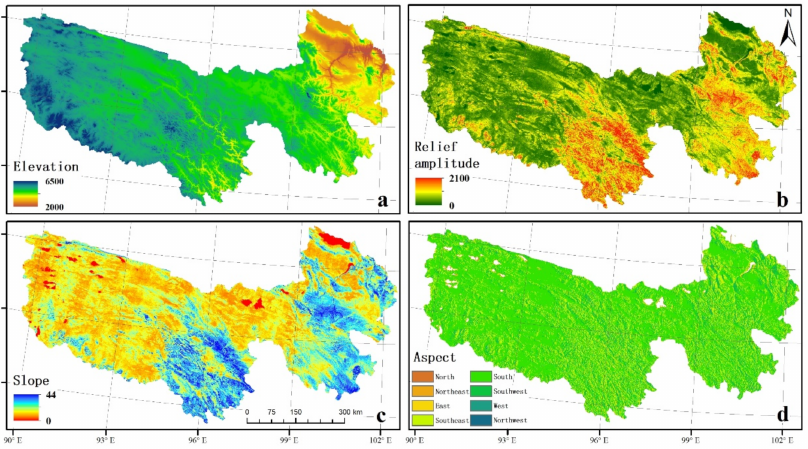
Figure 3. Various topographic factors in the TRSR: ( a ) elevation, ( b ) relief amplitude, ( c ) slope, and ( d )